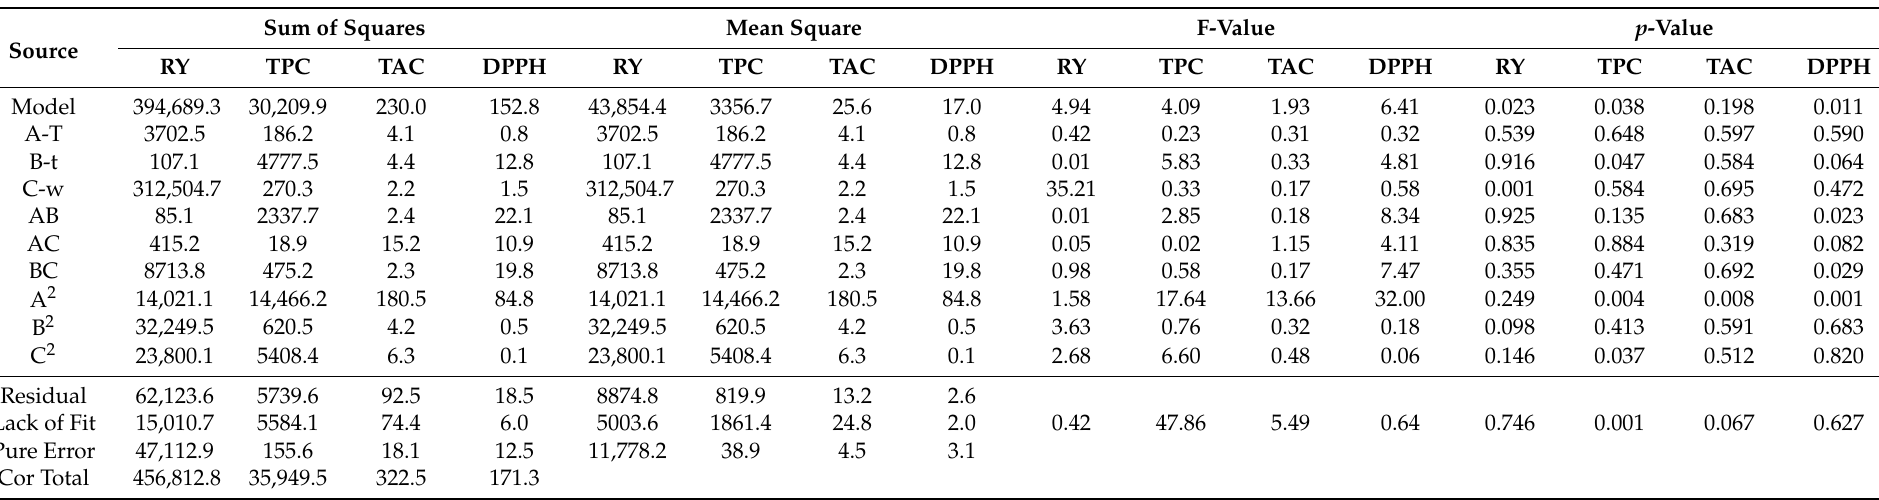
Table 2. ANOVA results for optimizing extraction conditions for biologically active substances from R. rosea (L.) when NADES choline chloride + malonic acid are